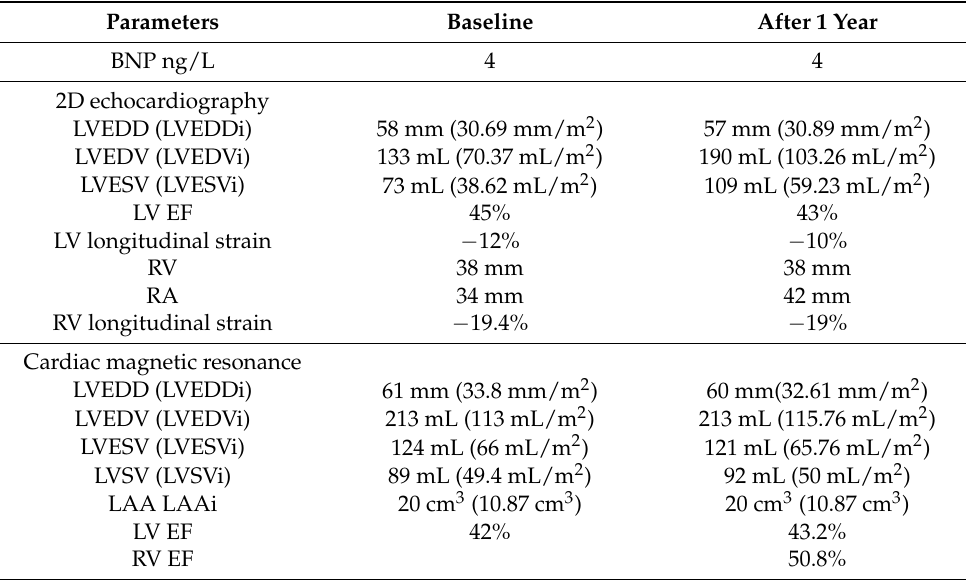
Table 2. Dynamics of cardiac structure and function assessed by 2D echocardiography and CMR at baseline and after 1